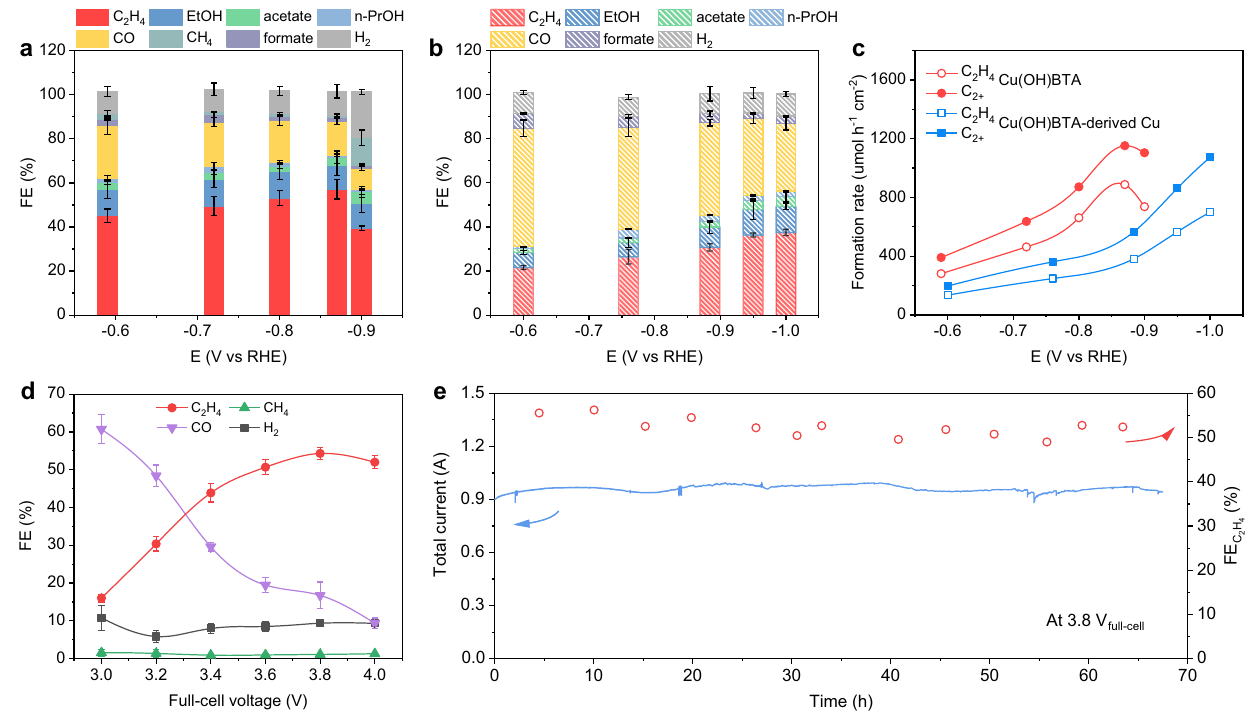
Fig.2|PerformancesofCO 2 RRoverCu(OH)BTA. Faradaicef fi ciencies(FEs)ofall products under different applied potentials over Cu(OH)BTA ( a ) and Cu(OH)BTA- derived Cu ( b ) in 1M KOH electrolyte. c The formation rates of C 2+ products and C 2 H 4 under different applied potentials over Cu(OH)BTA and Cu(OH)BTA-derived Cu in1M KOH electrolyte. d FEs of allgasproducts atthe full-cell voltage range of